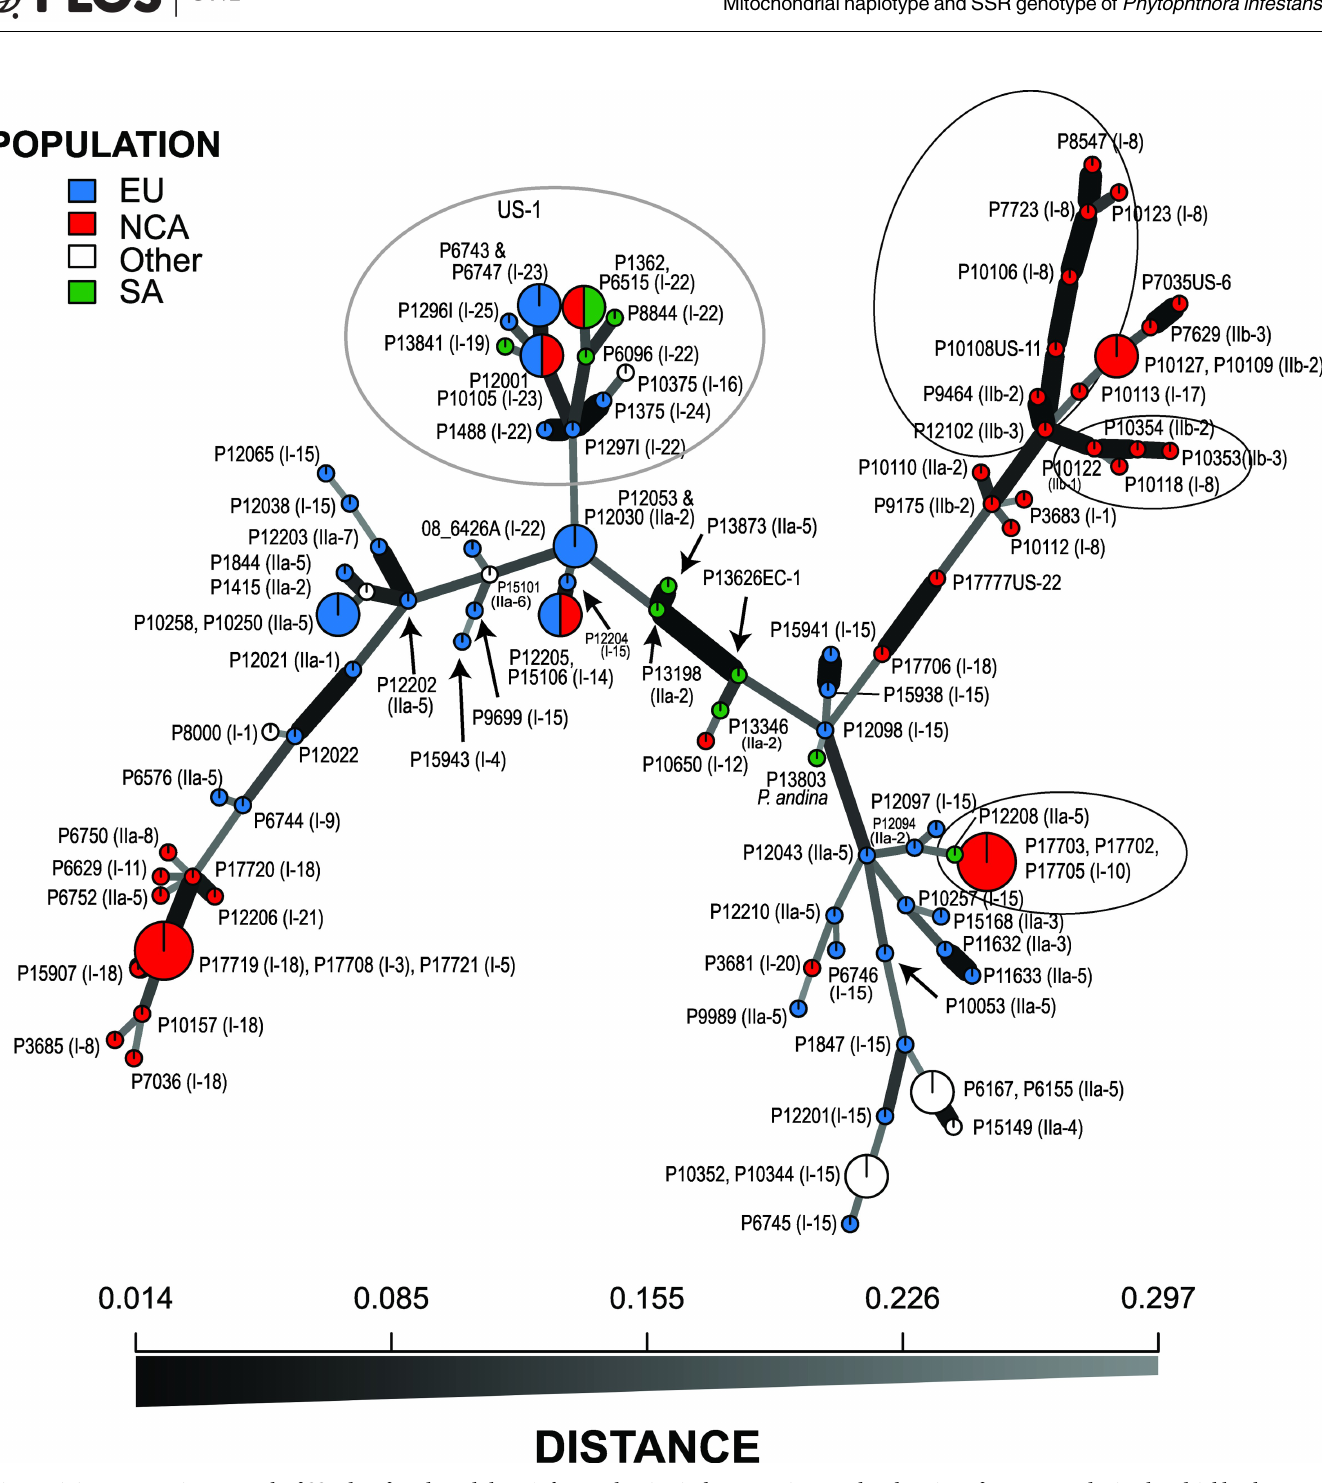
Fig 6. Minimum spanning network of SSR data for Phytophthora infestans showing isolate accession number, location of recovery and mitochondrial haplotype indicated in the brackets. Circled areas represent the branch of US-1 isolates or portions of the analysis where closely affiliated isolates based on SSR analysis have different mitochondrial